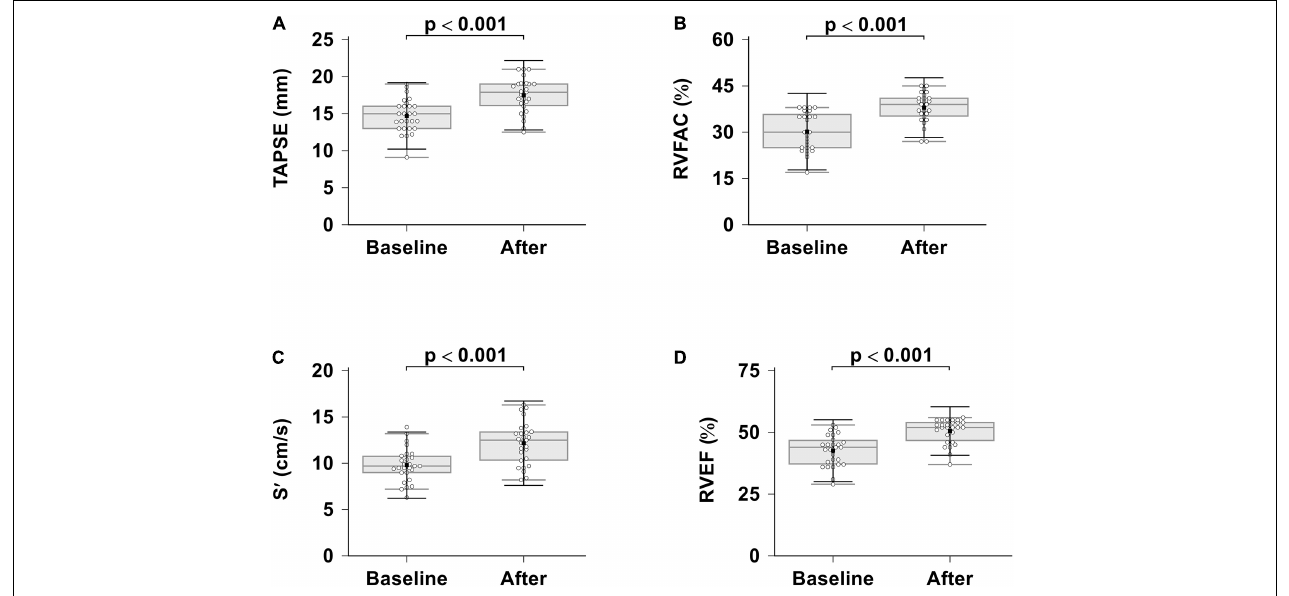
FIGURE 2 | Effects of ambrisentan plus PDE-5i combination therapy on RV systolic function. (A) TAPSE; (B) RVFAC; (C) S’; (D) RVEF. TAPSE, tricuspid annular plane systolic excursion; RVFAC, right ventricular fractional area change; S’, tricuspid annular systolic velocity; RVEF, right ventricular ejection fraction.